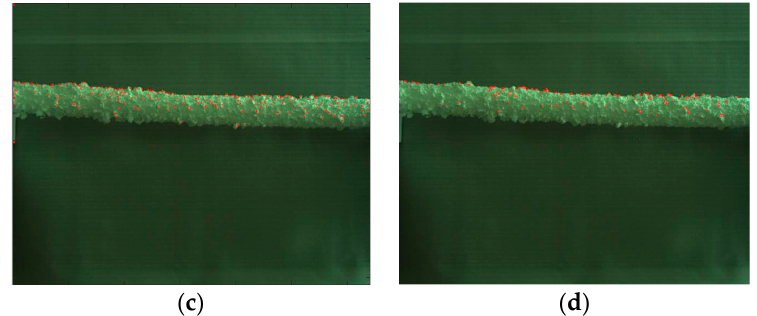
Figure 8. Keypoint detection examples on the collected dataset. ( a ) DOG; ( b ) Hessian; ( c ) Harris; ( d ) FAST.